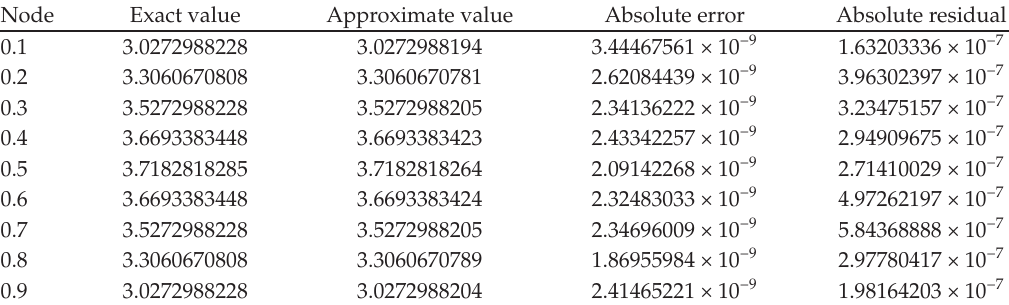
Table 4: Numerical results for Problem 2.